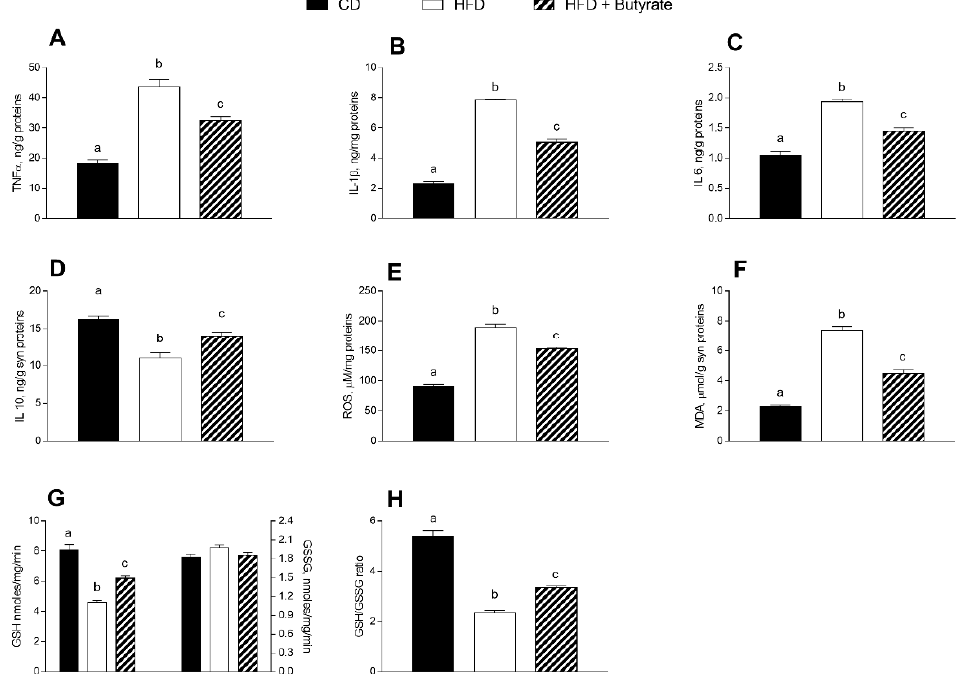
Figure 4. Effects of butyrate treatment on inflammation and oxidative stress in the synaptic fraction in diet-induced obese mice: ( A ) TNF- α ; ( B ) IL-1 β ; ( C ) IL-6; ( D ) IL-10; ( E ) ROS; ( F ) MDA; ( G ) glutathione (GSH) and oxidized glutathione (GSSG) and ( H ) GSH/GSSG ratio are reported. Data are shown as means ± SEM from n = 6 animals/group. Different letters (a,b,c) on top of the bars indicate statistically significant differences ( p < 0.05) among groups.